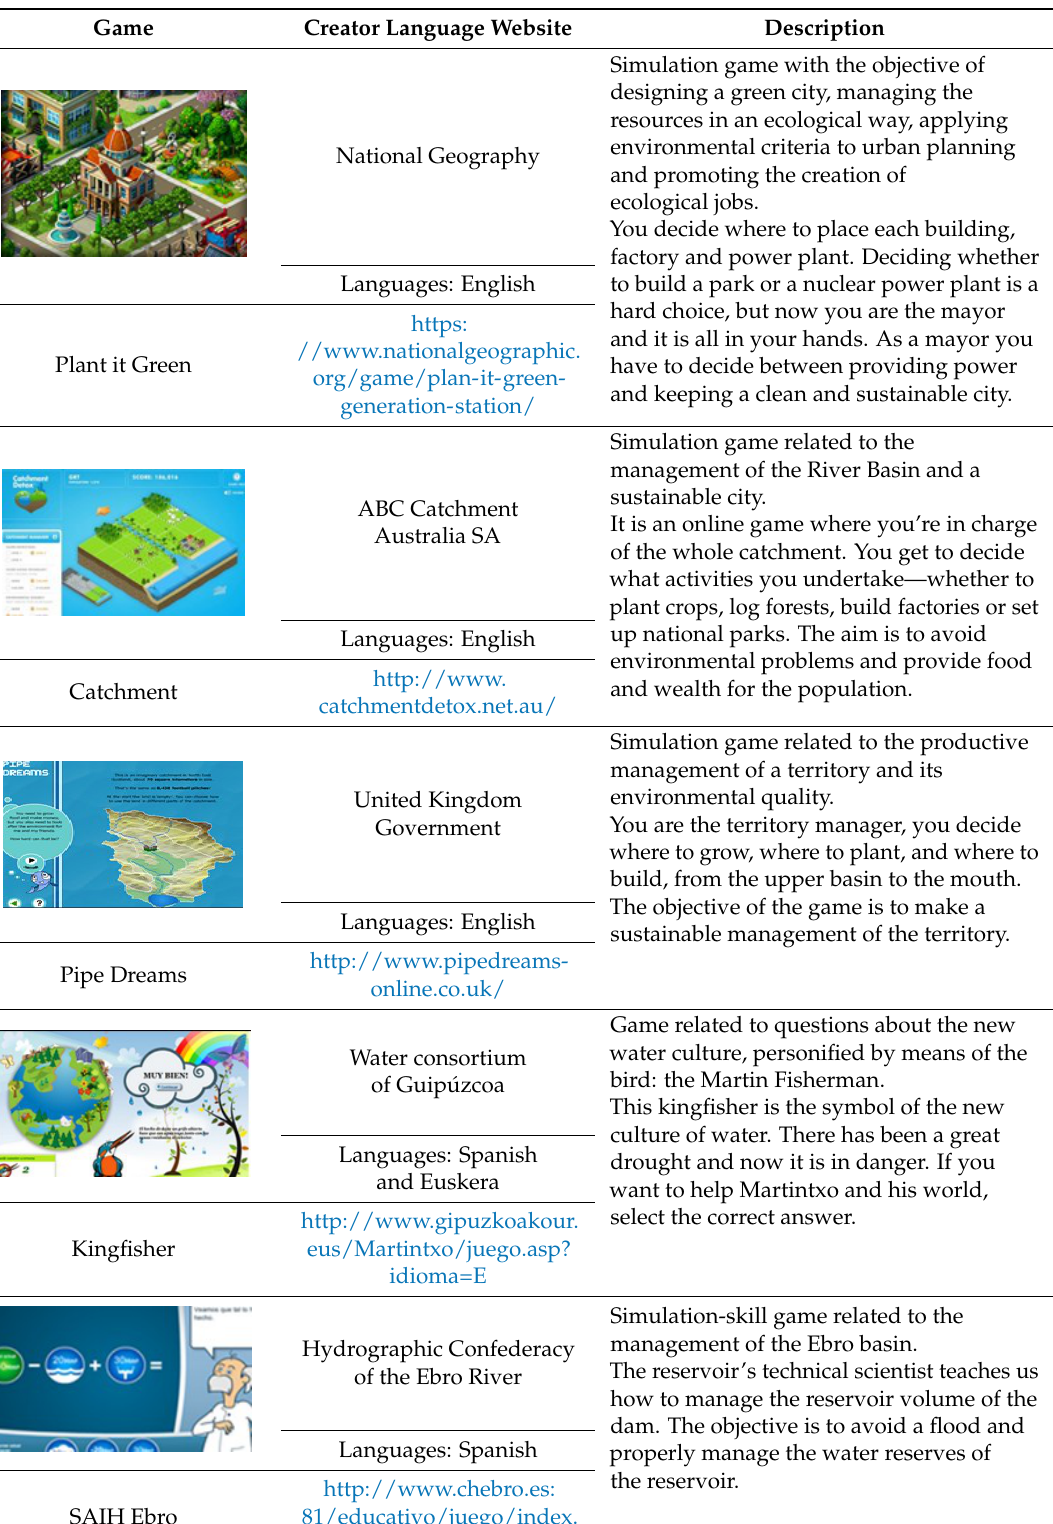
Table 1. Study simple of games.